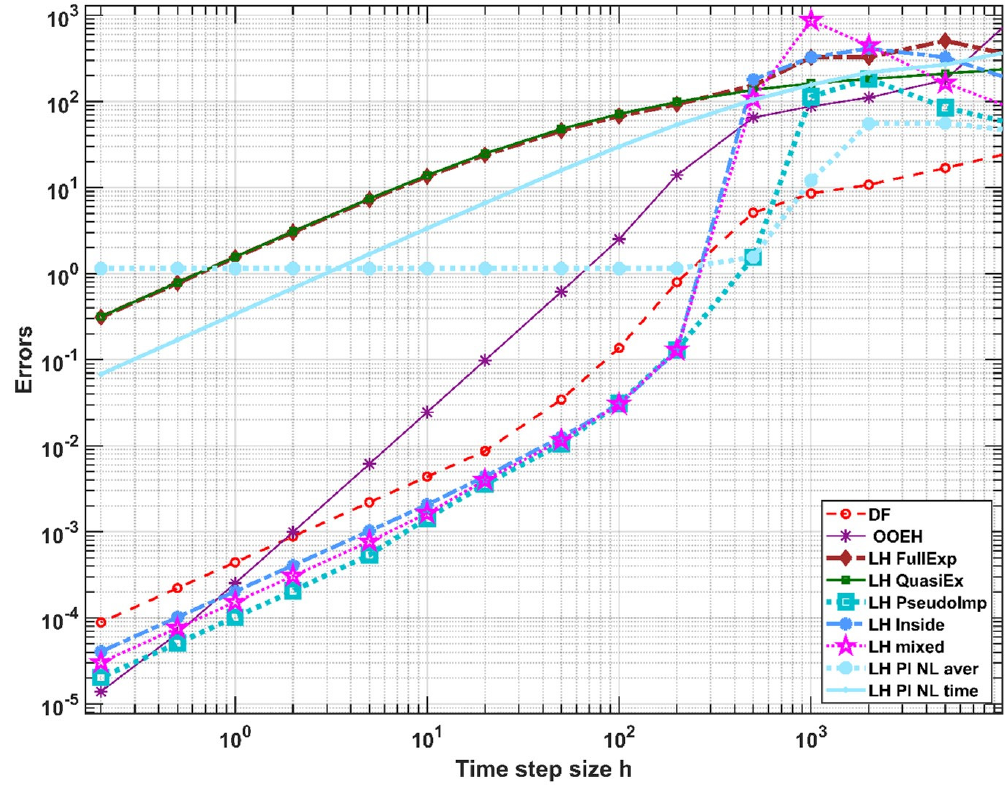
Figure 15. The maximum errors as a function of h for the equidistant mesh (Experiment 7) in the case of convection and radiation boundary conditions.